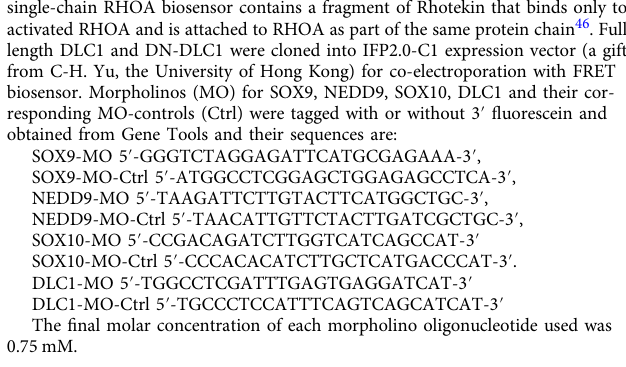
Fig. 6 Interaction between NEDD9 and DLC1 is required for RHOA polarity and directed NC migration. a Processed FRET signal images of cross-sections from embryos electroporated with the FRET probe plus NEDD9-MO ( n = 146/17 embryos), NEDD9 ( n = 168/13 embryos) or DN-DLC1+ NEDD9 ( n = 152/ 13 embryos). NCCs are marked by SOX9 immuno fl uorescence and nuclei are stained with DAPI. The magni fi ed area and selected cells are marked with dotted squares. White arrowheads indicate FRET signal. Scale bars: 20 μ m. b Quanti fi cation of the total FRET index of NCCs electroporated with the indicated constructs. Quanti fi cation of the ratio of the FRET index between the back and front of NCCs electroporated with the indicated constructs (control, n = 425/25 embryos). Mean ± s.e.m.; Student ’ s t -test, ** p < 0.001; Bonferroni multiple comparison test, *** p < 0.0001 c Processed FRET signal images of time-lapse series of migrating NCCs expressing NEDD9-MO ( n = 97/15 explants), DN-DLC1+ NEDD9-MO ( n = 92/19 explants) and NEDD9 ( n = 106/16 explants). Scale bars: 20 μ m. d Heat maps representing the FRET index as a function of time at the back or front, and the FRET ratio between the back and front of 12 selected NCCs expressing NEDD9-MO, e DN-DLC1 + NEDD9, and f NEDD9. g In situ hybridization of SOX10 3 ’ UTR in embryos electroporated with DN-DLC1 ( n = 9), NEDD9 ( n = 10), NEDD9-MO ( n = 10) and DN-DLC1 + NEDD9 ( n = 9). Black arrowheads indicate reduced SOX103 ’ UTR expression in the transfected sides. Scale bar, 10 µ m. h Quanti fi cation of the number of GFP + NCCs expressing HNK-1 + in embryos electroporated with the indicated constructs. Mean ± s.e.m. Bonferroni multiple comparison test, ** p < 0.001; *** p <